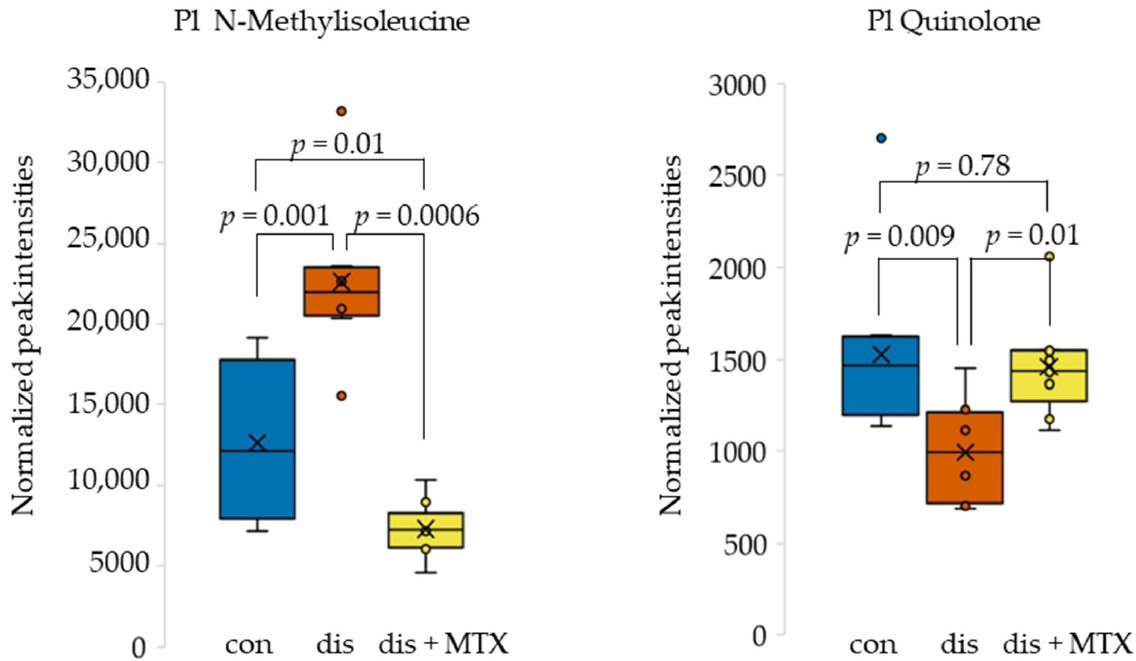
Figure 5. Box and whisker plots of plasma metabolite levels for metabolites identified as altered in disease mice and corrected in disease mice receiving MTX therapy. Control (blue; n = 10); disease (orange; n = 8); and dis + MTX (yellow; n = 9).